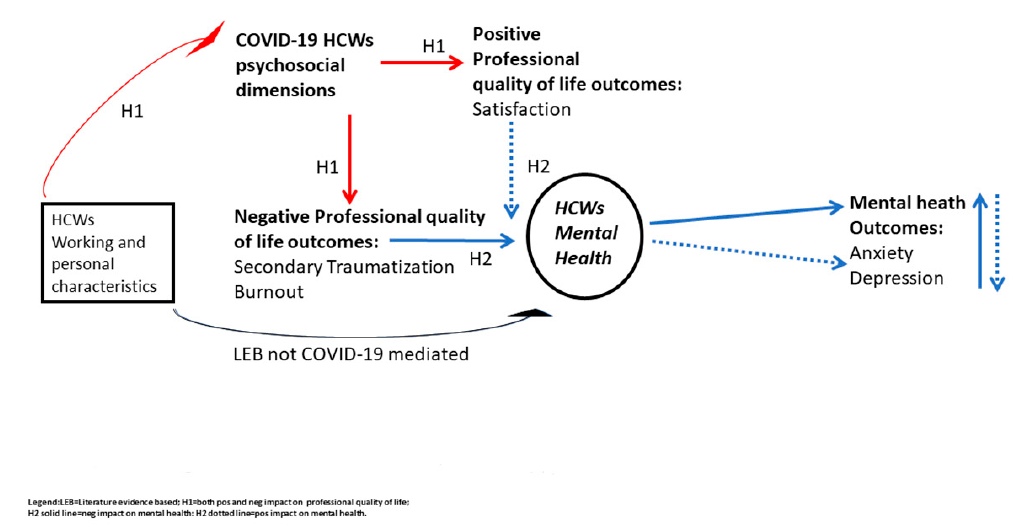
Figure 1. Overall theoretical model of study hypothesis (H1 and H2).